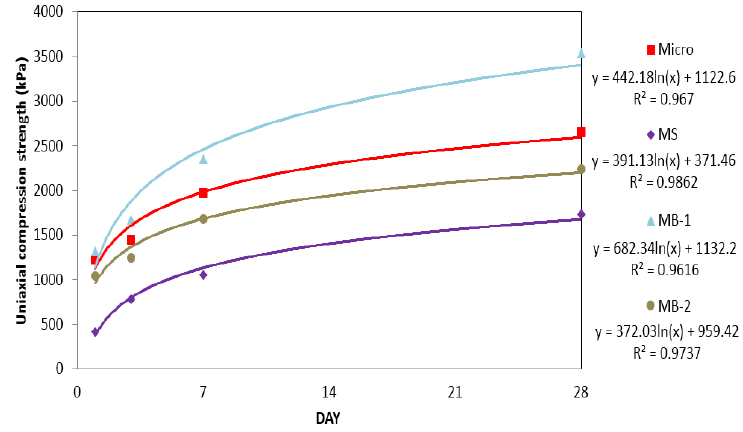
Figure 7. Uniaxial compression strength of the improved micro cement.